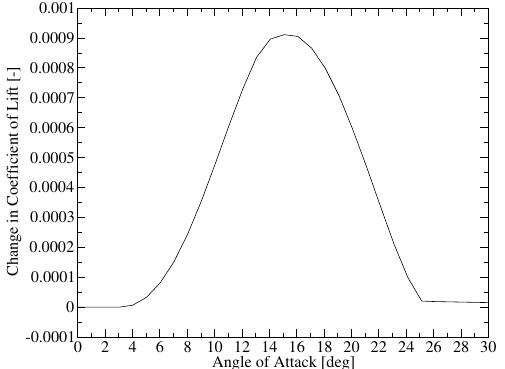
Figure 8. Coefficient of Lift Perturbation.